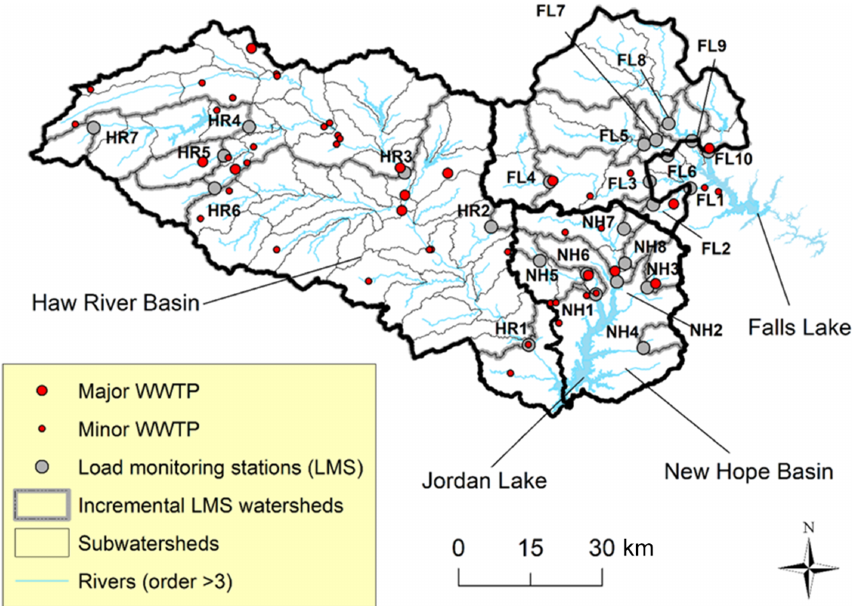
Figure 1. The load monitoring sites (LMSs) in Jordan and Falls Lake watersheds shown with their incremental watersheds. Also shown are the 79 subwatersheds along with point sources (major and minor wastewater treatment plants – WWTP). Major basins are delineated by thick black